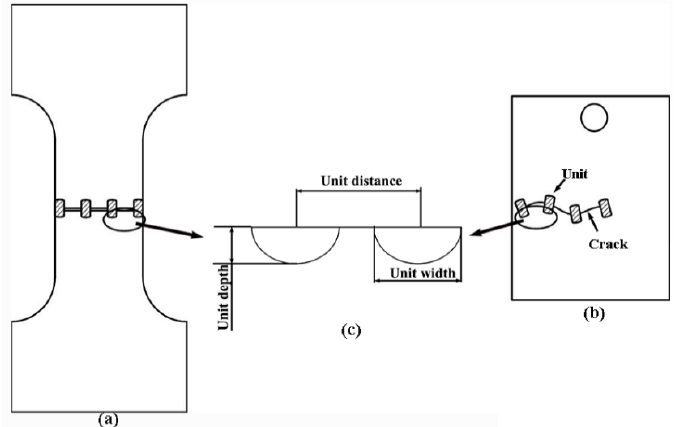
Figure 4. Sketch of crack repair. ( a ) Tensile test sample, ( b ) thermal fatigue test sample, and ( c ) the cross section of the sample.